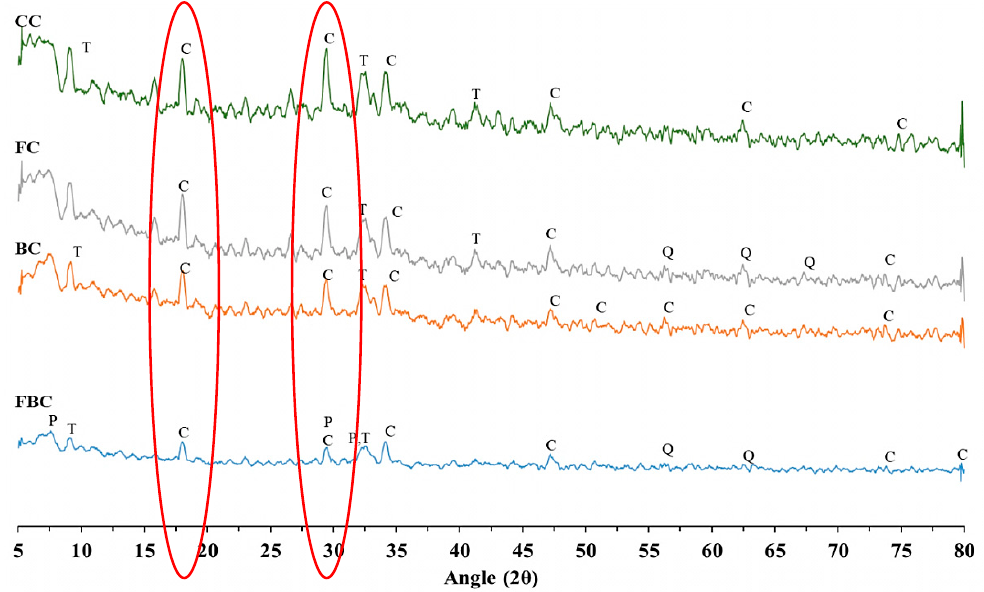
Figure 10. XRD pattern for mass concrete samples containing BT and FA.